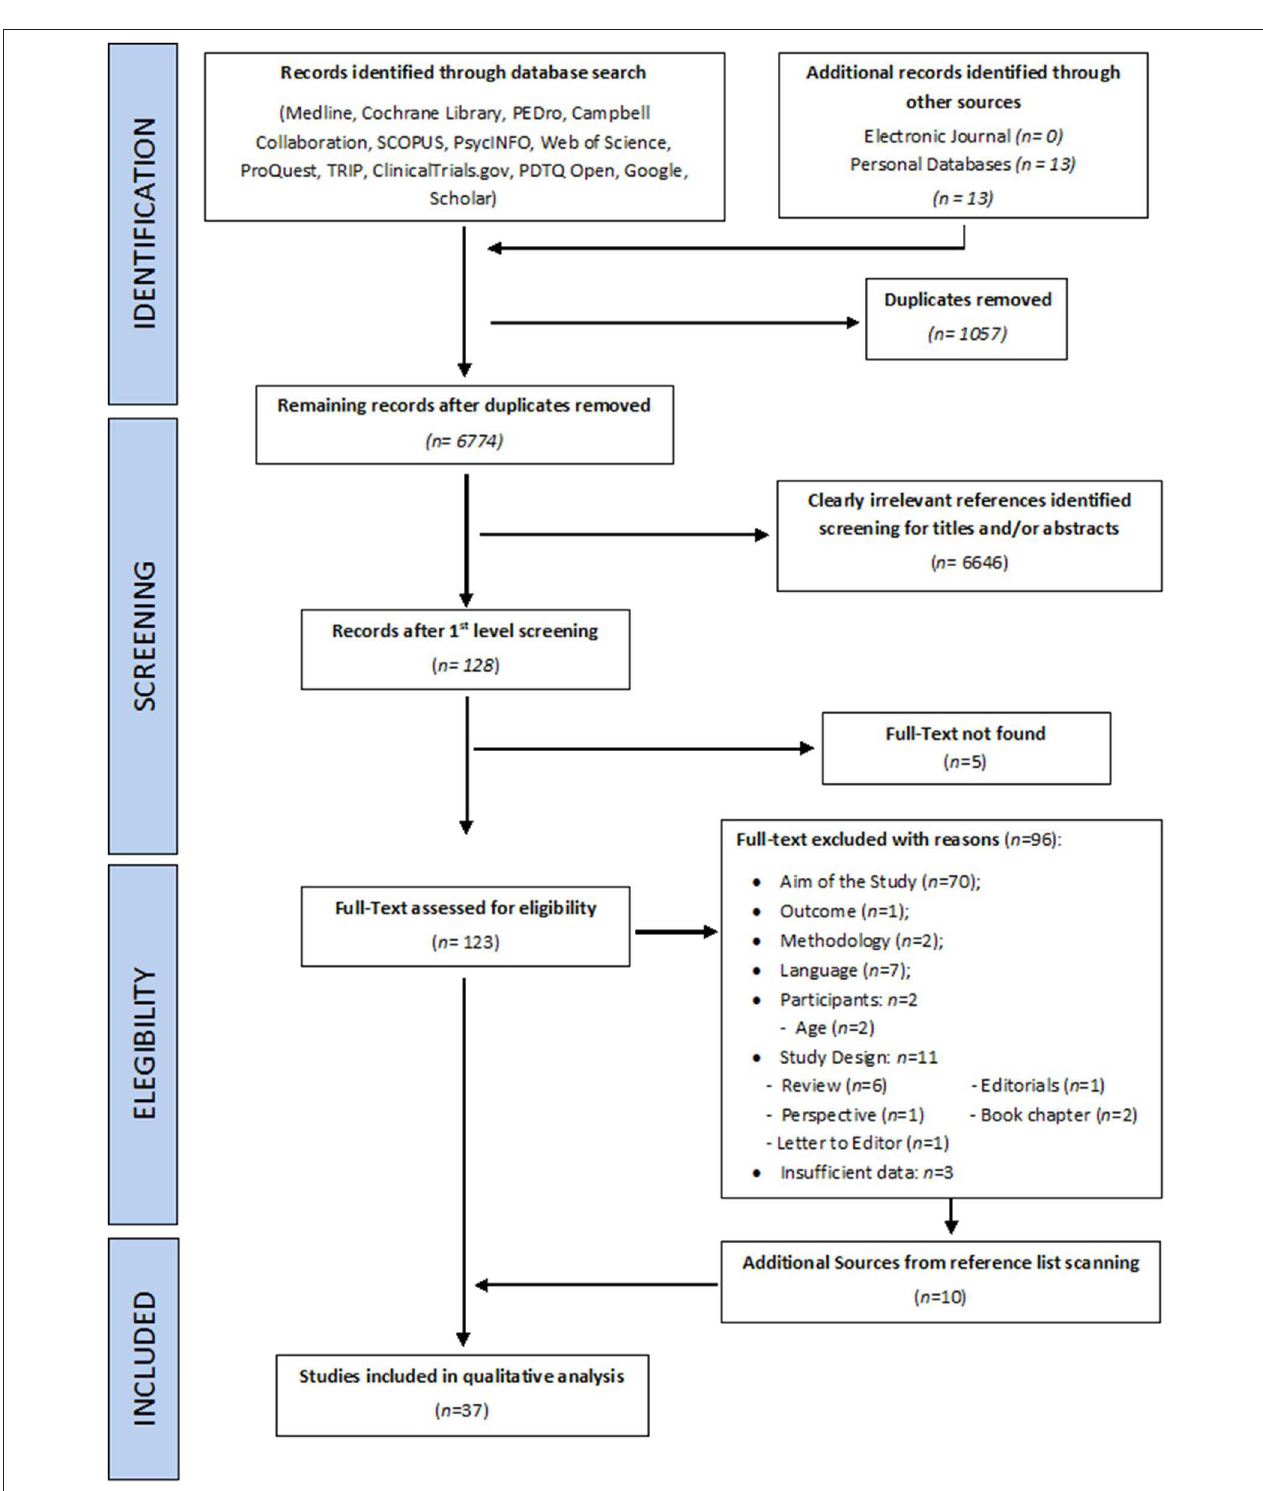
FIGURE 2 | PRISMA flow diagram detailing the selection of sources of evidence.